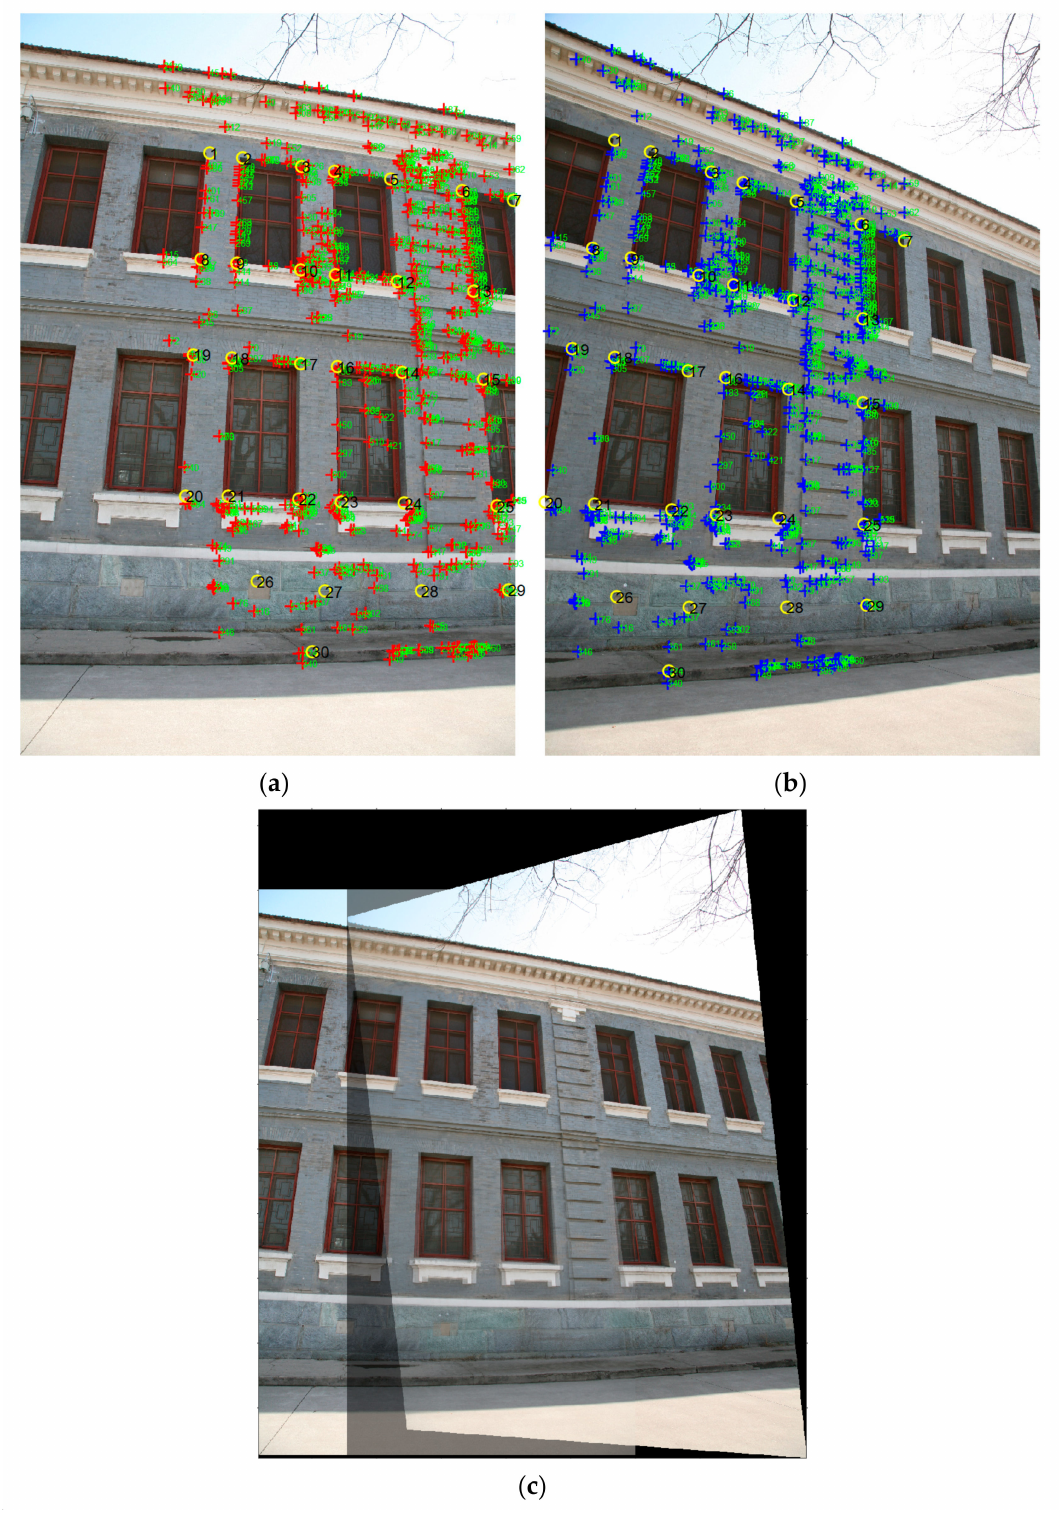
Figure 5. Primary data of the real scene (Robot Vision Group (ia.ac.cn)). ( a ) Left image. ( b ) Right image. ( c ) Registered image. The ‘+’ and ‘o’ points with the same number on the left and right images represent a pair of matching points and a pair of control points,